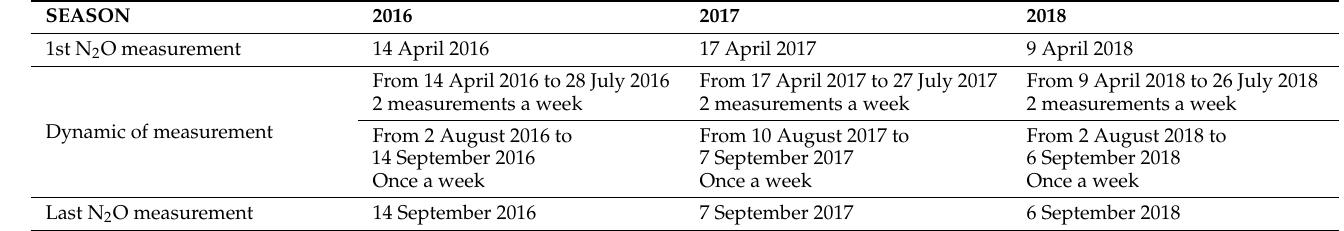
Table 4. Dynamic of emission measurements during the three seasons